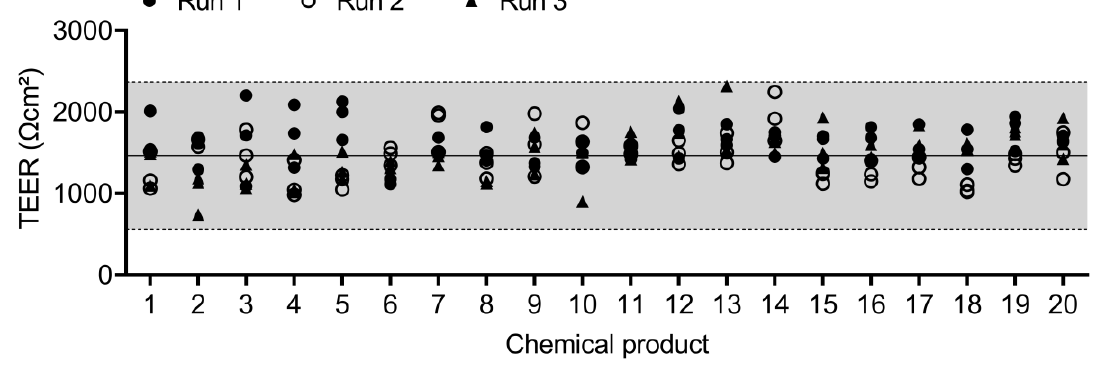
Figure 3. TEER values of QileX-RhE models used in this